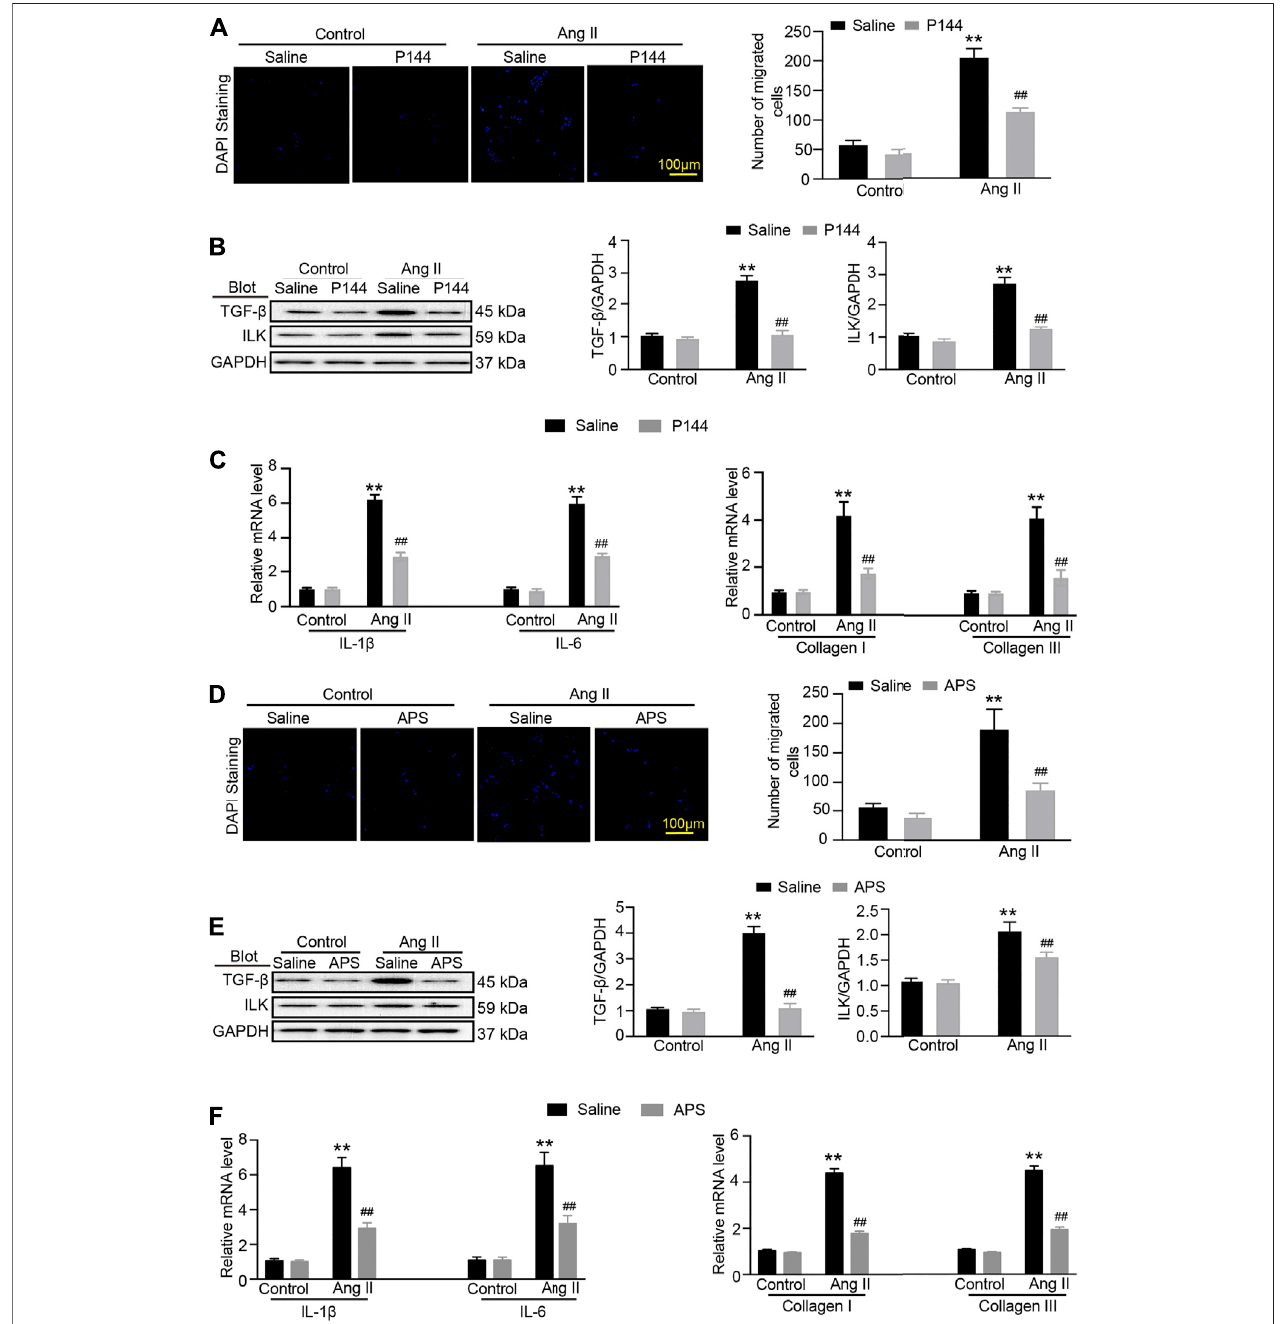
FIGURE6 | APS decreases the expression of ILK throughregulating theTGF- β pathway in Ang-II-treated HK-2 cells. (A) Migration ability ofiBMDM was assessed using a transwell assay. iBMDM was added to the upper chambers, and conditioned media obtained from Ang II and P144-pretreated HK-2 cells were added to the lower wells. The migrated iBMDM was stained with DAPI to visualize nuclei (left), and the migrated cells were quanti fi ed (right, scale bar 100 μ m). (B) Immunoblotting analysisofTGF- β 1andILKproteinineachgroup( n (cid:1) 3pergroup). (C) qPCRanalysisofIL-1 β ,IL-6,collagenI,andcollagenIIImRNAexpressionlevelsinthekidney ( n (cid:1) 6). (D) Migration ability of iBMDM to Ang II and APS-pretreated HK-2 cells was added as described above. The migrated iBMDM was stained with DAPI to visualize nuclei (left), and the migrated cells were quanti fi ed (right, scale bar 100 μ m). (E) Immunoblotting analysis of TGF- β 1 and ILK protein in each group ( n (cid:1) 3 per group). (F) qPCR analysis of IL-1 β , IL-6, collagen I, and collagen III mRNA expression levels in the kidney ( n (cid:1) 6). ** P < 0.01 versus control group. ## P < 0.01 versus Ang II + P144 group or Ang II + APS group.